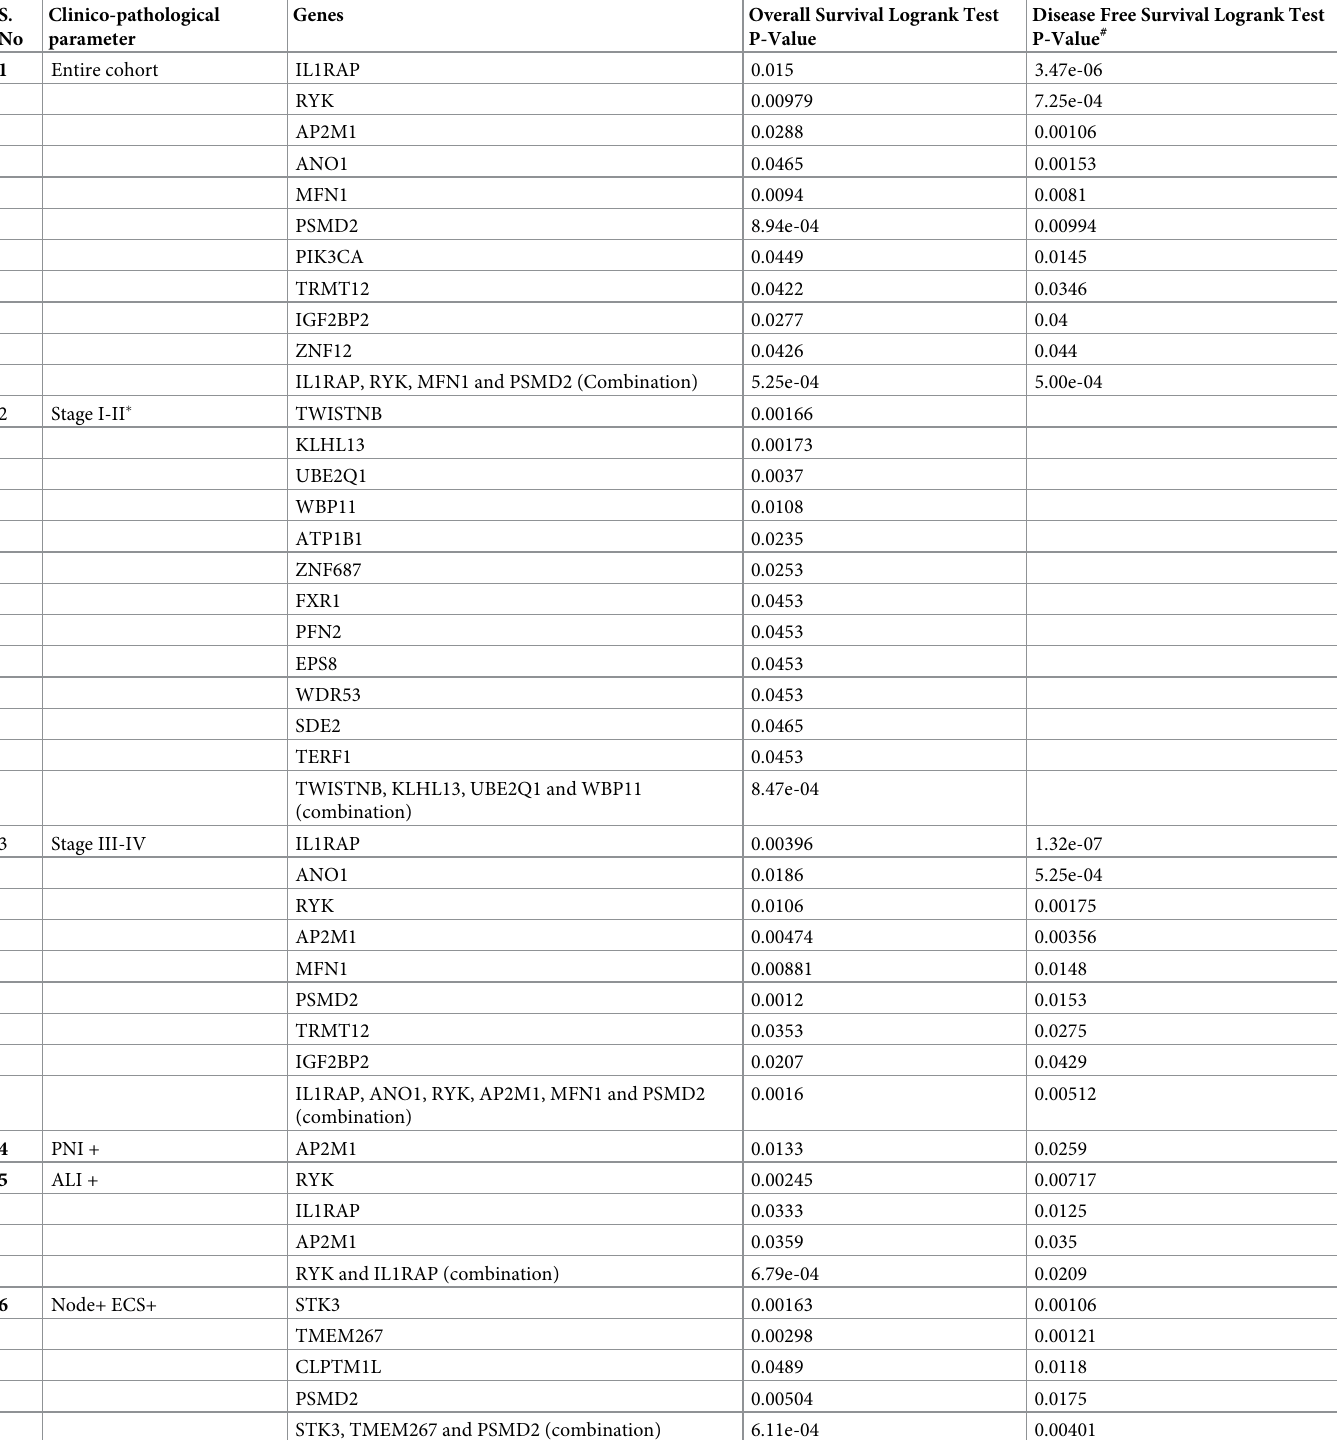
Table 4. List of significant genes with both disease free and overall survival of different clinic-pathological parameters in TCGA laryngopharyngeal cohort. S.